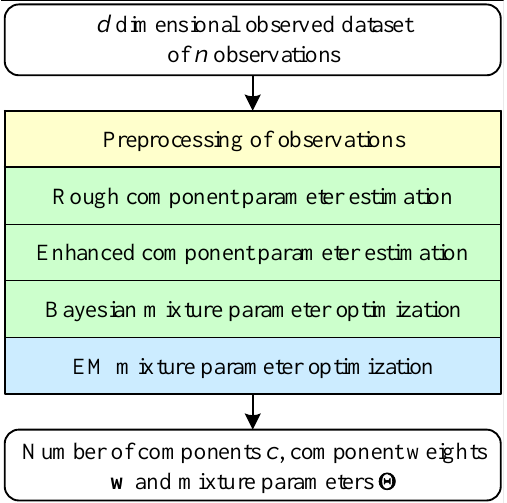
Figure 2. Flowchart of REBMIX &